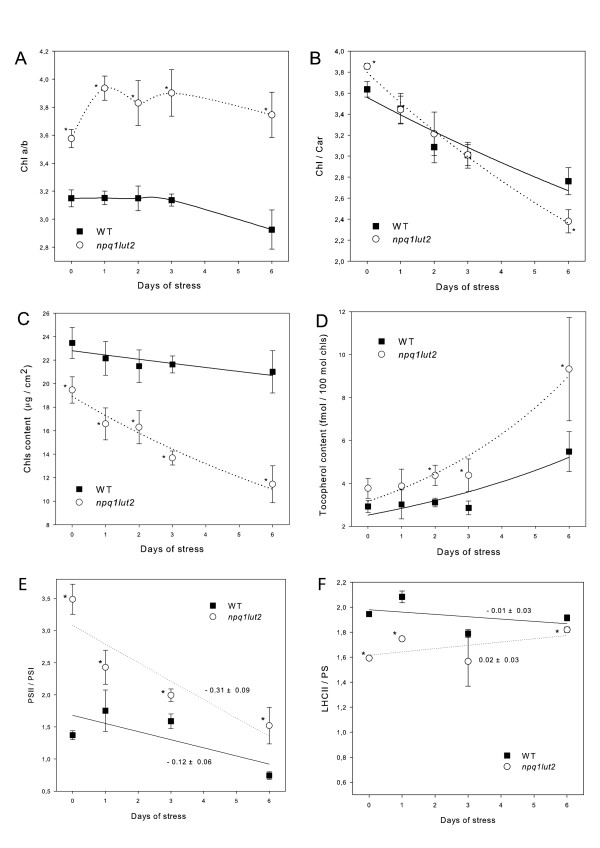
Biochemical characterization of thylakoid membrane composition under high light stress. Chlorophylls (A, C), carotenoids (B) and tocopherol (D) content of WT and lut2npq1 plants were measured on leaf acetone extracts as described in "Material and Methods". (E, F) Stoichiometry between photosynthetic pigment-binding complexes under high light stress. PSII/PSI ratio (E) and biochemical antenna size (LHCII/PS ratio, F) were determined by both non-denaturing Deriphat-PAGE and immunoblot-titration using specific antibodies (see "Material and Methods" for details). Symbols and error bars show respectively means ± SD.